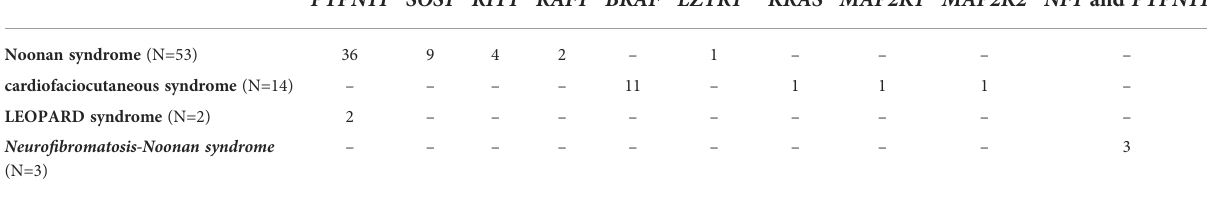
TABLE 1 The study cohort. The different RASopathies are subdivided taking into account the involved disease